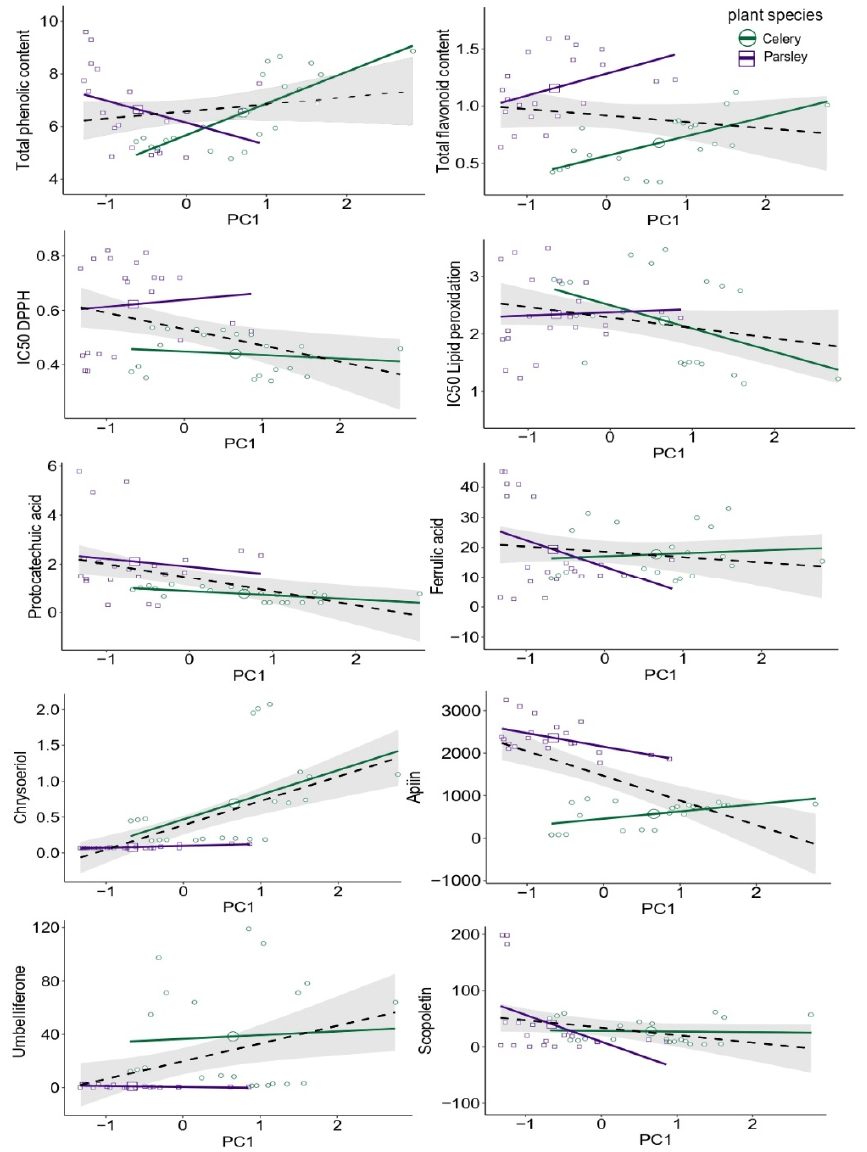
Figure 5. Standardized major axis (SMA) regression model of total phenolic, flavonoid content, IC50 of DPPH, and lipid peroxidation, as well as selected metabolites in relation to the variance contri- bution in PC1 from the trace elements data set. The black line reflects the overall SMA regression fit based on both species, celery, and parsley, while the gray area is showing the 95% confidence inter- val.